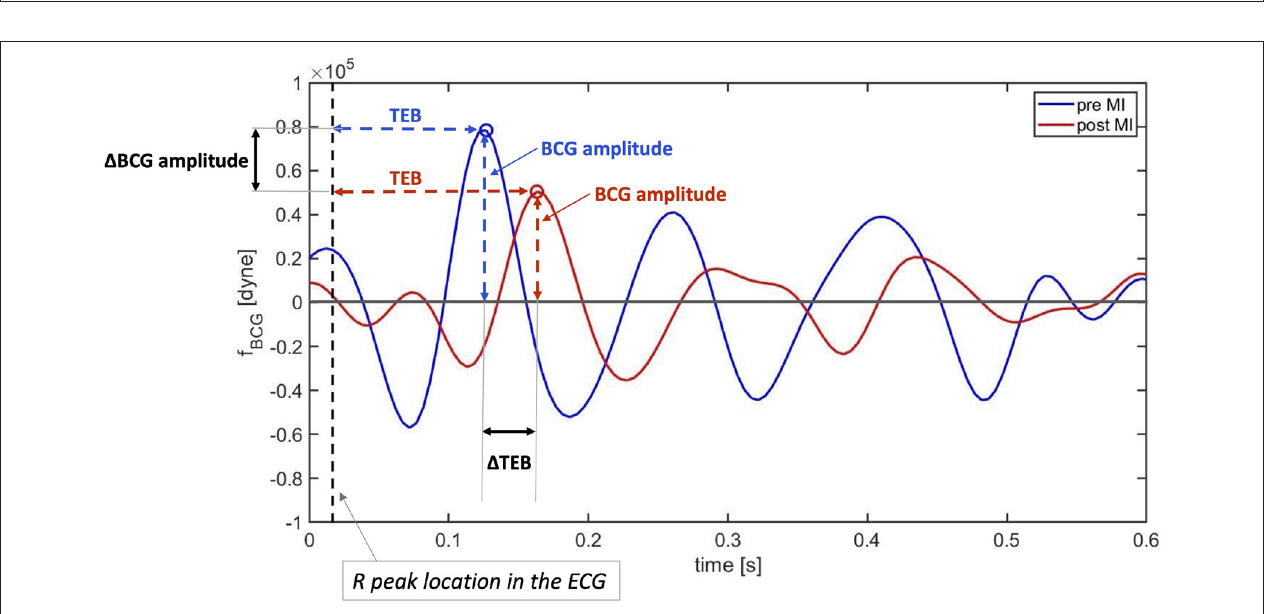
henceforth referred to as f BCG , is not the exact counterpart of the model-predicted BCG waveform denoted as f A . On the one hand, the model-predicted waveform f A corresponds to the BCG signal acquired on human subjects in the head-to-toe direction, as described and validated in ( 29). On the other hand, the experimental waveform f BCG is obtained from the accelerometer placed under the swine neck, where the floor-to-ceiling (and not the head-to-tail) direction provides the stronger signal among the three acquisition axes. We remind that the floor-to-ceiling